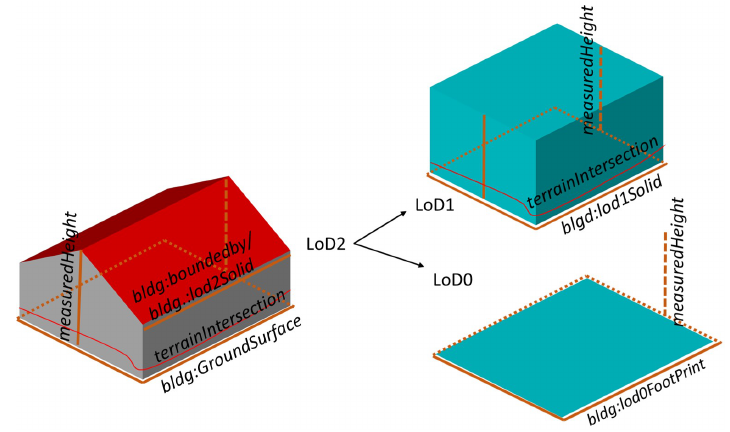
Figure 7. An overview of downscaling LoD2 models to LoD1 and LoD0.